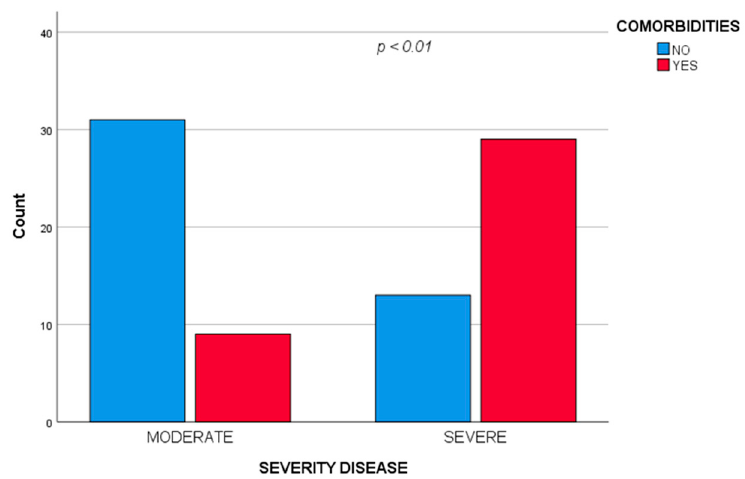
Figure 1. Severe form of disease statistically significant associated with comorbidities. When comparing the two groups of age (infants and child), the results obtained were: fever ( χ 2 = 5.896, p = 0.02), pneumonia ( χ 2 = 6.185, p = 0.02) and comorbidities ( χ 2 = 4.571, p = 0.04) were significantly associated with infants. Regarding the biochemical values, hyperlactatemia (Lactate > 1.5 mmol/L) was significantly associated with the under one year of age group ( χ 2 = 14.154, p < 0.001); the odds ratio of hyperlactatemia is 8.152 times higher in the age group under one year compared to the child group (Figure 2); high levels of CPR were associated with the child group ( χ 2 = 4.952, p = 0.04).